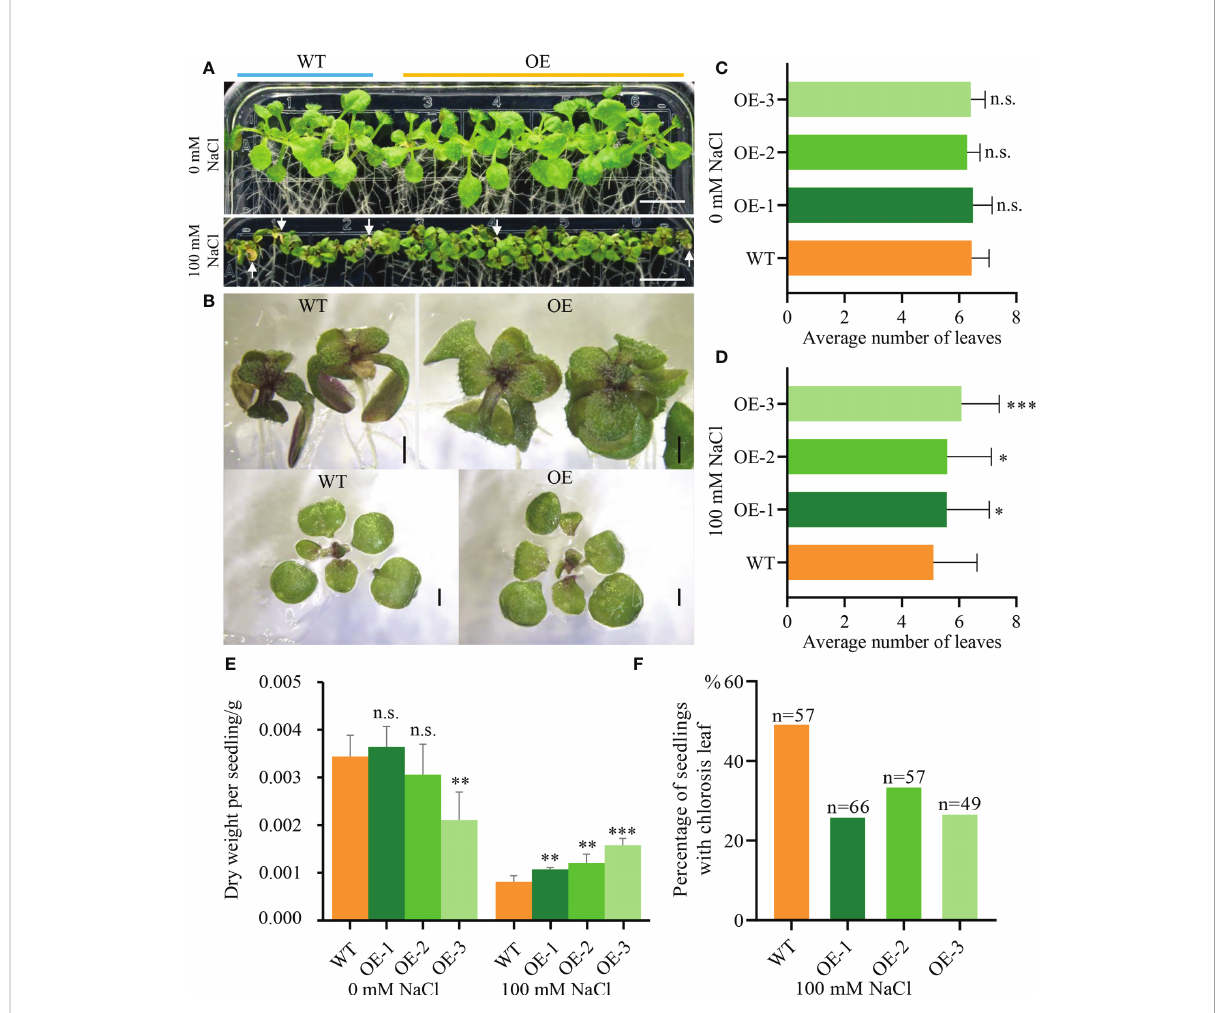
FIGURE 2 NbCIPK25 overexpression maintains the Arabidopsis growth under salt condition. (A) The phenotype of 5-day-old WT and NbCIPK25 overexpressing plants treated with 0 mM NaCl or 100 mM NaCl (showing at left side of panel A ) for 7 days. Seedlings covered with blue line came from wild type (showing as WT) seeds. Seedlings under orange line were from transgenic seeds. OE represents NbCIPK25 overexpressing plants. The white arrow heads indicate chlorotic leaves. Scale bar: 1 cm. (B) Shoots and leaves of WT and NbCIPK25 transgenic plants treated with 100 mM NaCl for 7 days. Scale bar: 0.1 cm. (C – F) Statistical analysis for leaf number (C, D) , dry weight (E) , and percentage of seedlings with chlorotic leaves (F) in WT and transgenic plants treated with or without salt treatment. Data represent means ± SD from three biological replicates, statistics was analyzed by t-test using GraphPad Prism 8, ‘ * ’ p < 0.05, ‘ ** ’ p < 0.01, ‘ *** ’ p < 0.001, n.s., not signi fi cant; n, the number of examined